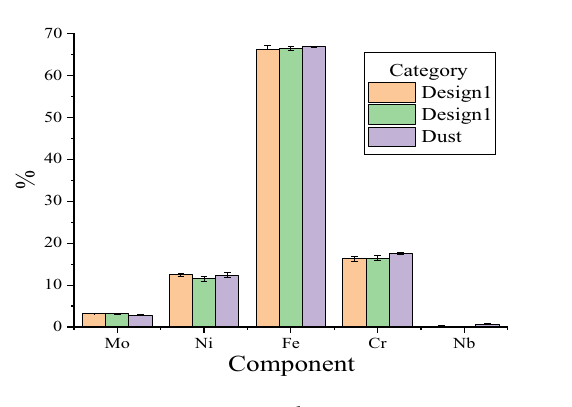
Figure 11. Measurement error